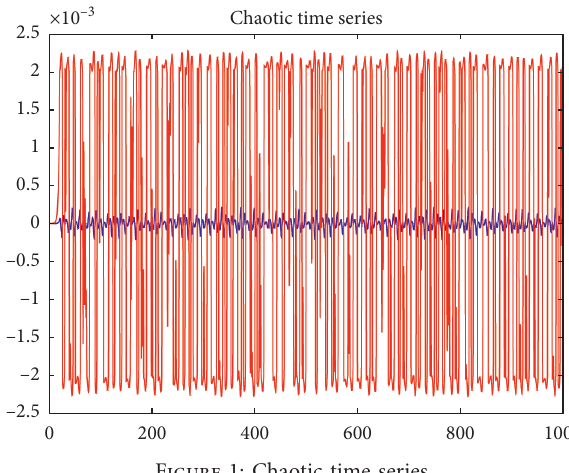
Figure 1: Chaotic time series.